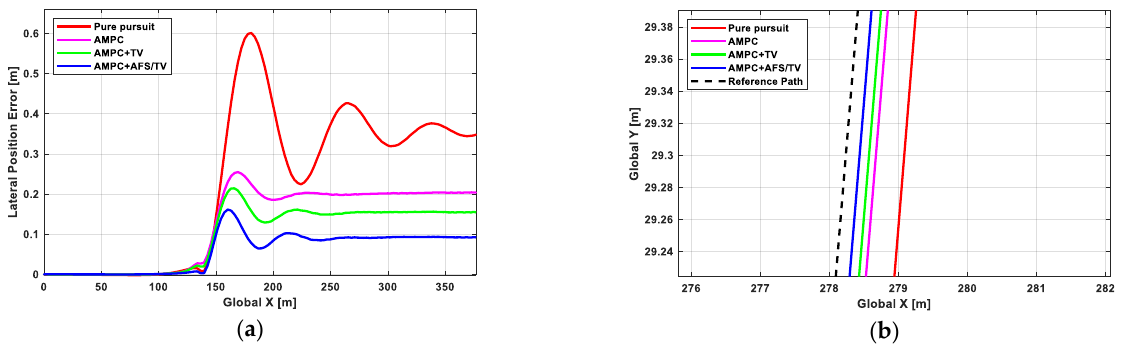
Figure 11. ( a ) Vehicle trajectory and ( b ) lateral error.